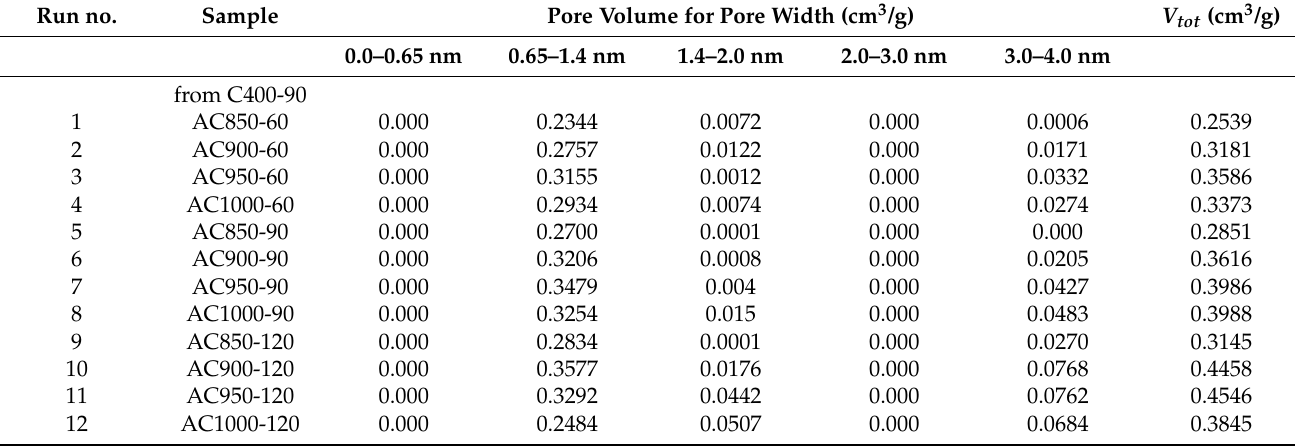
Distribution of pore volume for various pore sizes in activated carbon prepared under different preparation